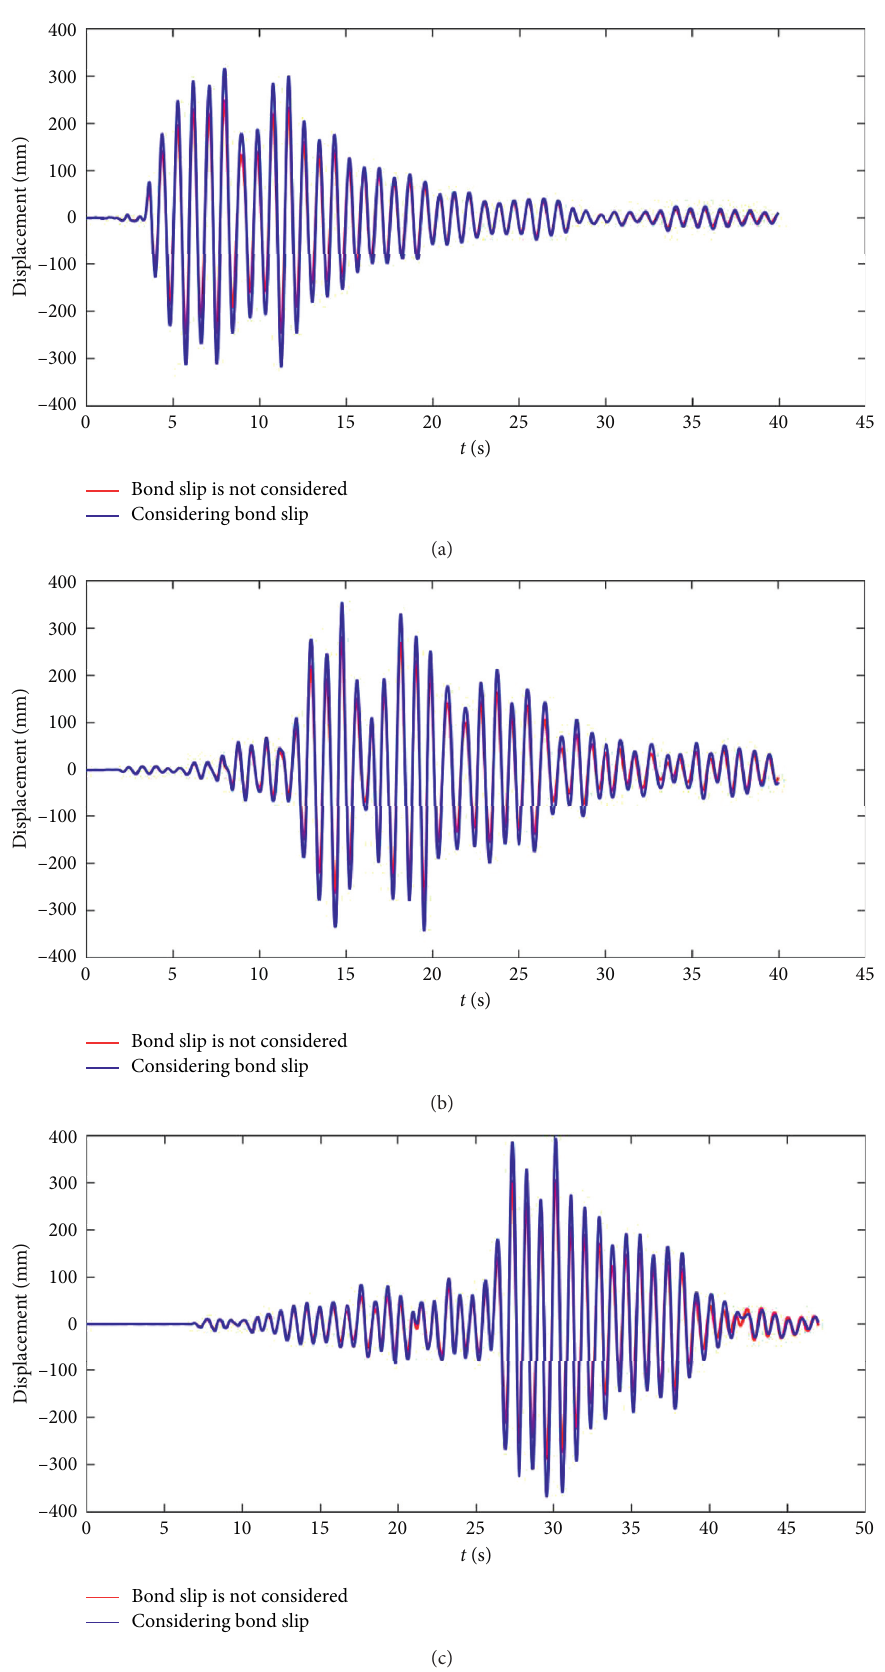
Figure 5: Displacement time-history curves of the pier top: (a) Northridge wave; (b) Taiwan wave; (c) Duzce